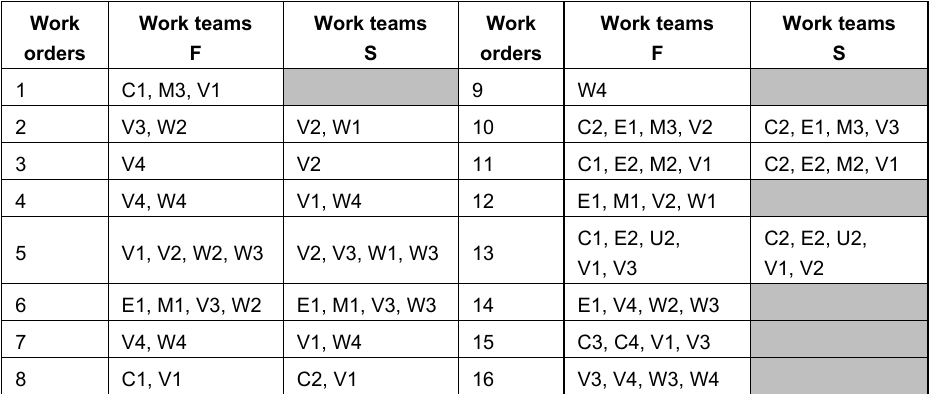
Table 1. Work orders and the work teams of first (F) and second (S)